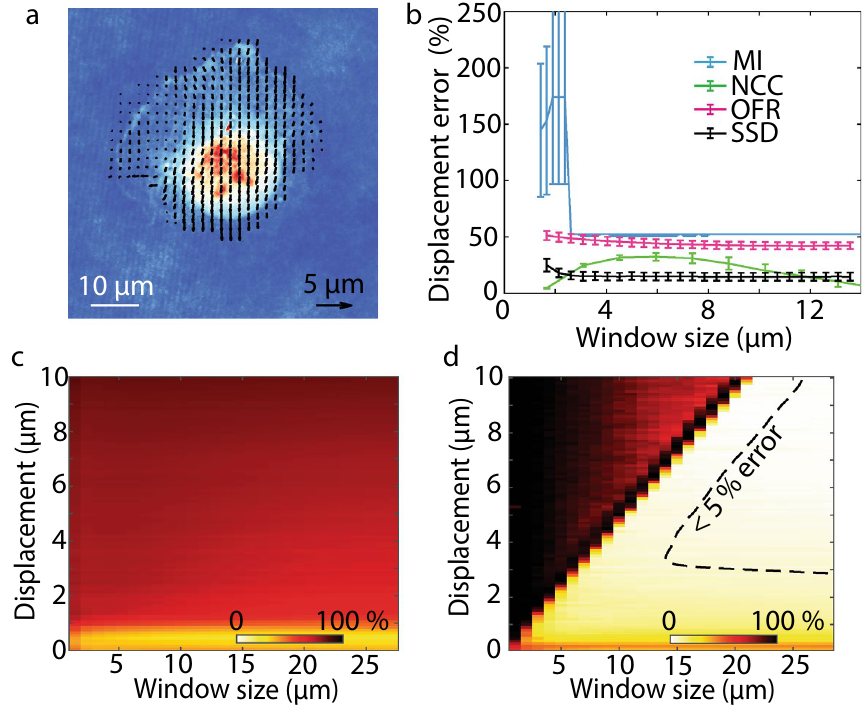
Figure 2. SSD image registration measures intracellular velocity from QPI data with higher accuracy than OFR, MI and NCC at most interrogation window sizes. ( a ) QPV on RPE fixed cell measures the intracellular displacement during microscope stage translation. ( b ) Comparison of displacement error, the percentage difference between the measured and expected displacements, for mutual information (MI), normalized cross correlation (NCC), optical flow reconstruction (OFR) and sum of squared difference (SSD) for intracellular velocity computation on QPI data at different interrogation window sizes shows SSD has highest accuracy at most window sizes (number of cells, n , = 11, error bar shows standard error of the mean, SEM). (c) Velocity accuracy versus both interrogation window size and displacements of RPE fixed cell using OFR shows that OFR is limited to measuring a very narrow range of displacements with acceptable accuracy ( n = 11). Yellow/white – high accuracy, red/black–low accuracy. ( d ) QPV velocity measurement accuracy versus interrogation window size and displacements of fixed RPE cells show typically less than 10% error when the interrogation window size is smaller than the displacement to be measured with a region of less than 5% error indicated as a dashed line ( n =